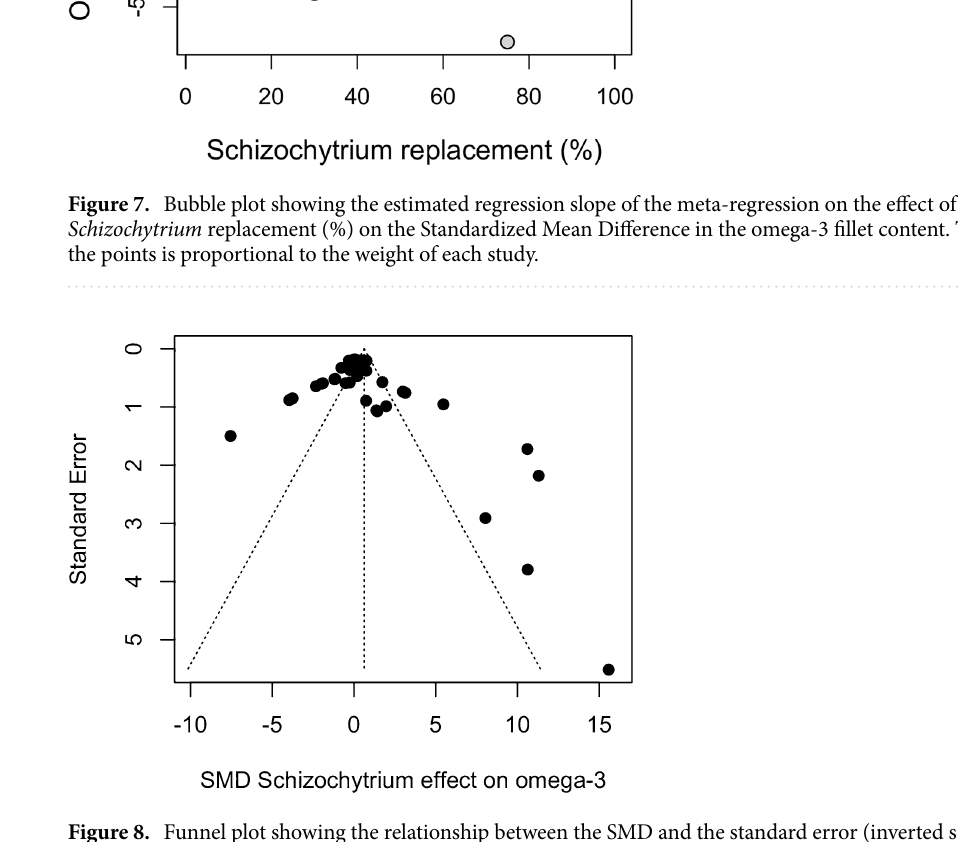
Figure 8. Funnel plot showing the relationship between the SMD and the standard error (inverted scale) for the effects of Schizochytrium replacement on omega-3 fillet content. Each point represents a treatment–control comparison and the dotted vertical line denotes the global SMD under a random effects model. An asymmetric distribution of points outside the funnel might be indicative of publication